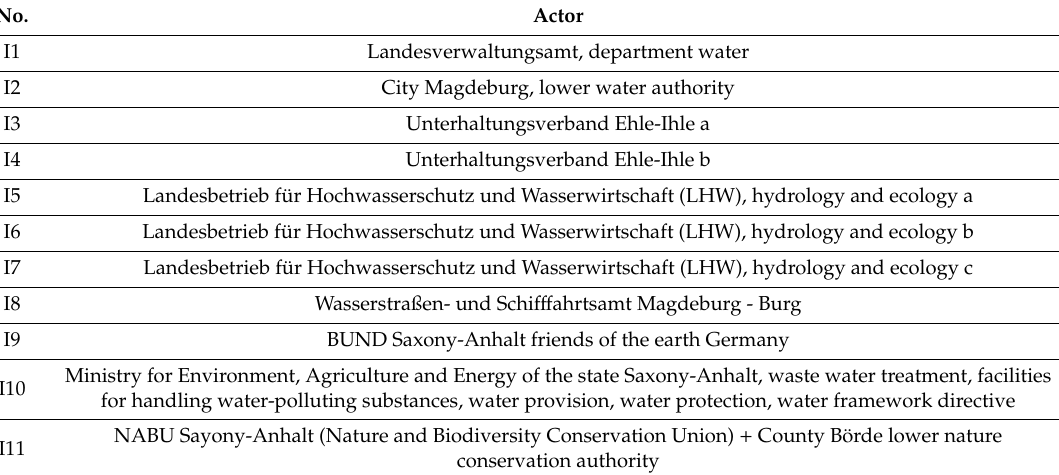
Table A1. Saxony-Anhalt: January 2017, March-June / August 2018.